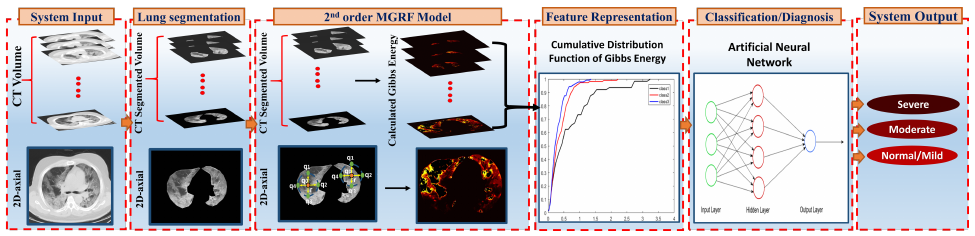
Figure 2. An illustrative framework for the proposed CAD system to detect the severity of COVID-19 through the CT